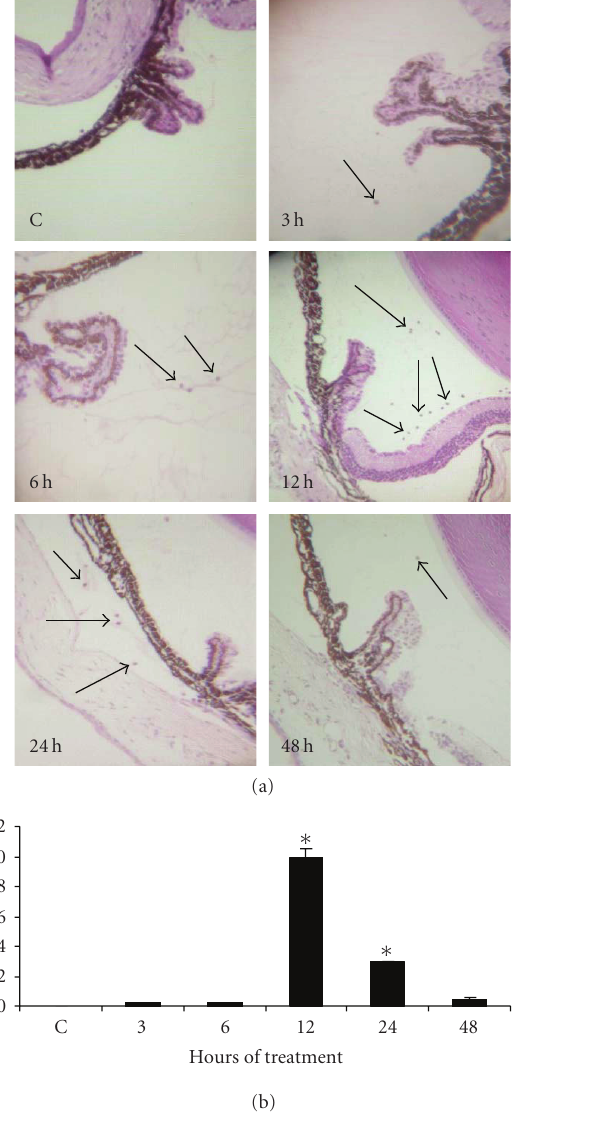
Figure 1: Histological and molecular analysis of the LPS-induced ocular inflammation . C3H/HeN mice were inoculated in the footpad with 200 μ g/50 μ L of LPS and the inflammation was analyzed at 3, 6, 12, 24, and 48 hours. Control mice (C) received a footpad injection of 50 μ L of sterile PBS. (a) histological analysis of leukocyte infiltration in the anterior chamber stained with hematoxylin-eosin (40x). The arrows point infiltrated cells. The figure shows a representative result of five mice studied in each time. (b) average of infiltrated leukocytes observed in (a). (c) average of semiquantitative analysis of IL-6 and TNF α mRNA expression. Asterisk indicates significant di ff erence compared with the control ( P < . 05) analyzed by Kruskal-Wallis and Turkey tests. (d) ocular expression of IL1 β protein in treated and untreated mice. Immunostaing of IL-1 β of untreated mouse (I) and treated mice at 12 hours posttreatment (II and III). (e) testis tissue was used as positive control of IL1 β expression; irrelevant antibody (I), IL-1 β antibody (II). Blue staining means positive